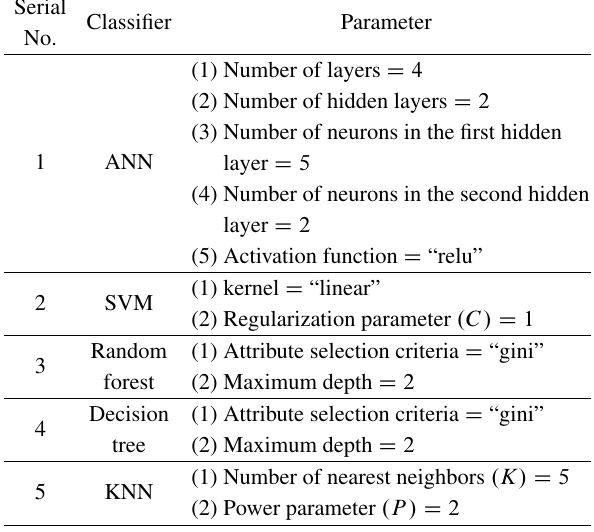
Table 2 Feature extraction for the sample tweets. Tweet